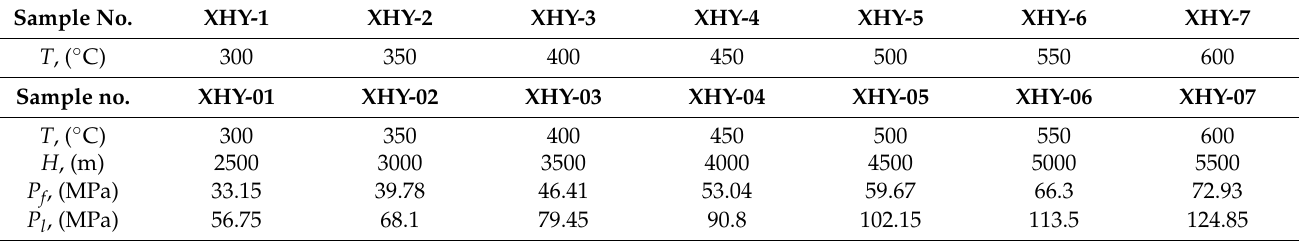
Table 1. Experimental conditions for open and semi-closed pyrolysis